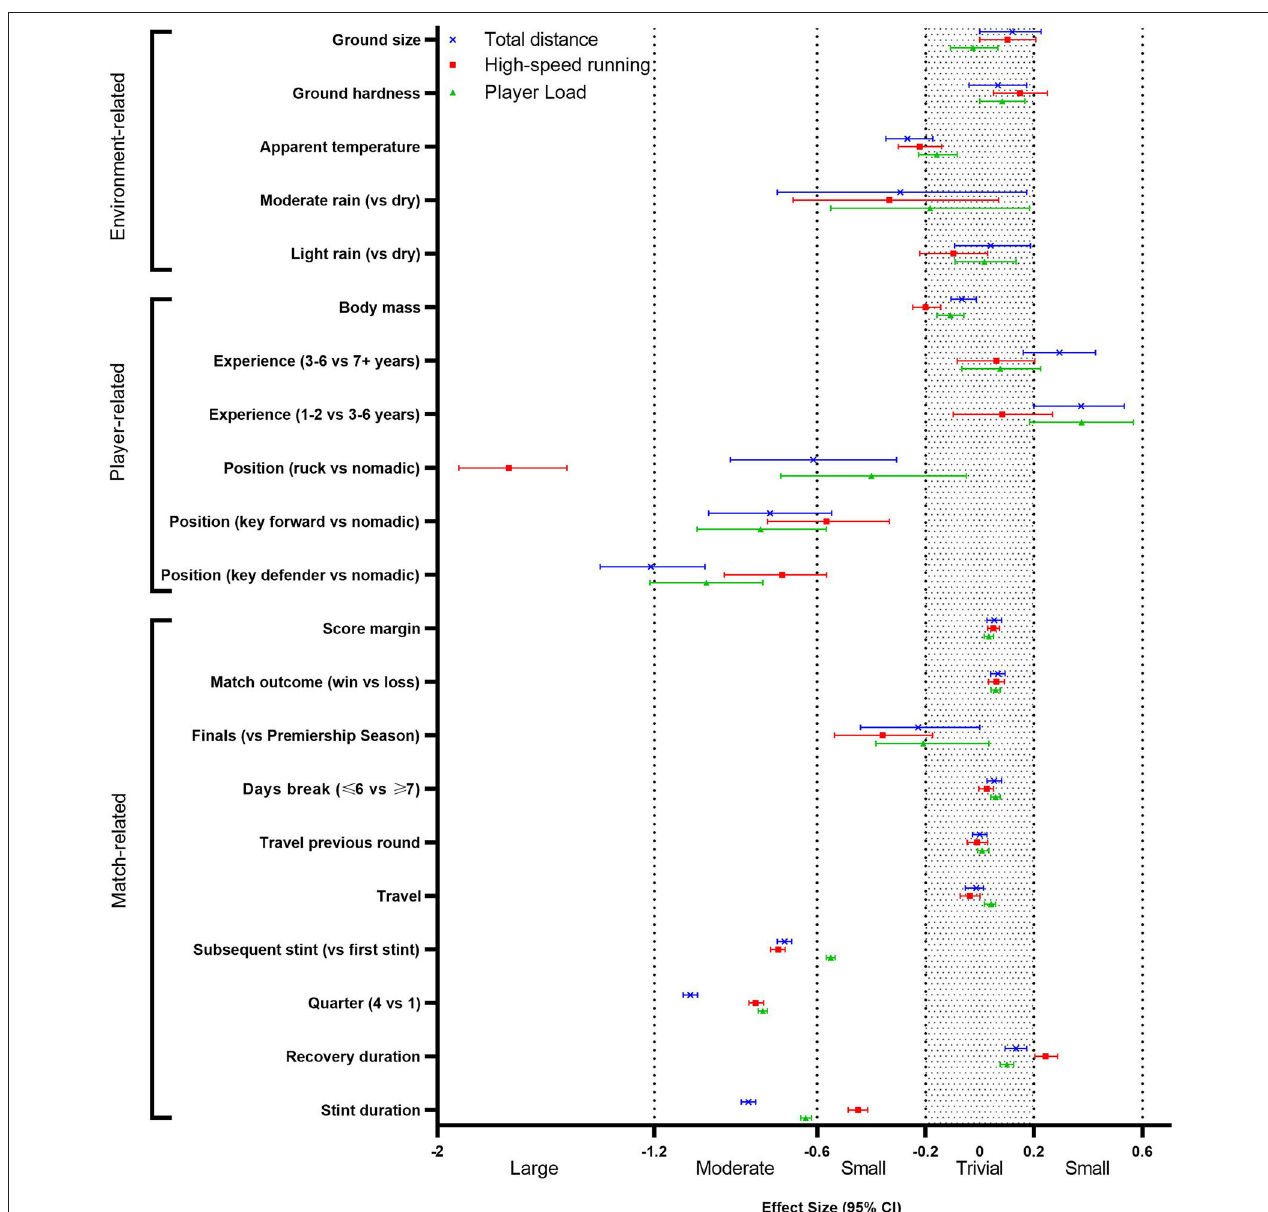
FIGURE 1 | Standardised effects of all independent variables on match activity